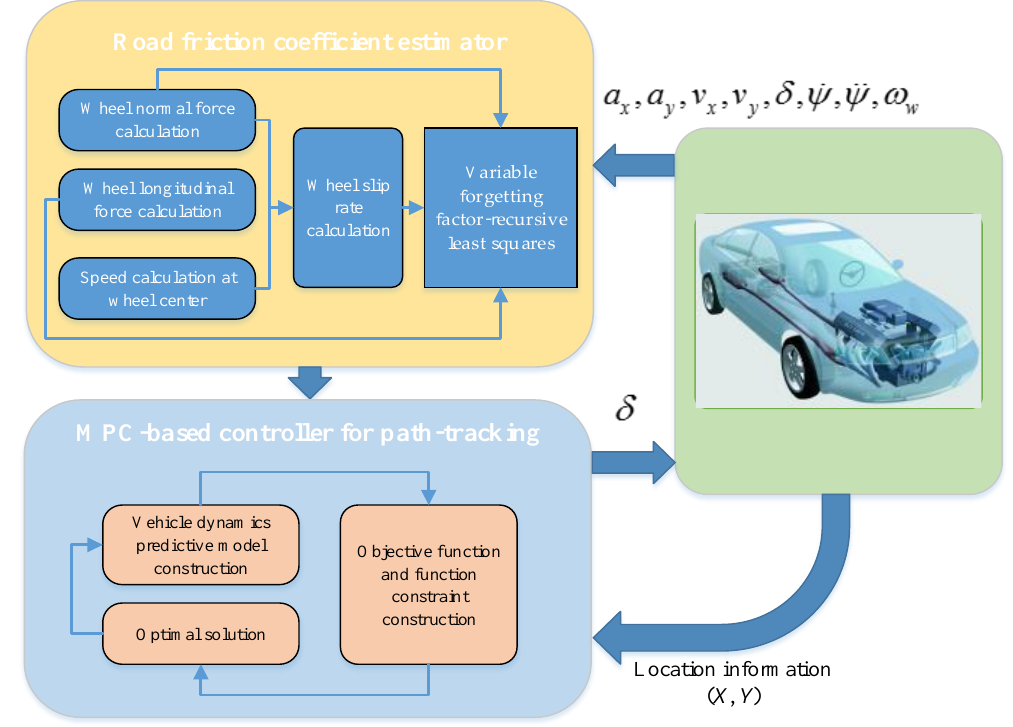
Figure 1. The framework of the system.